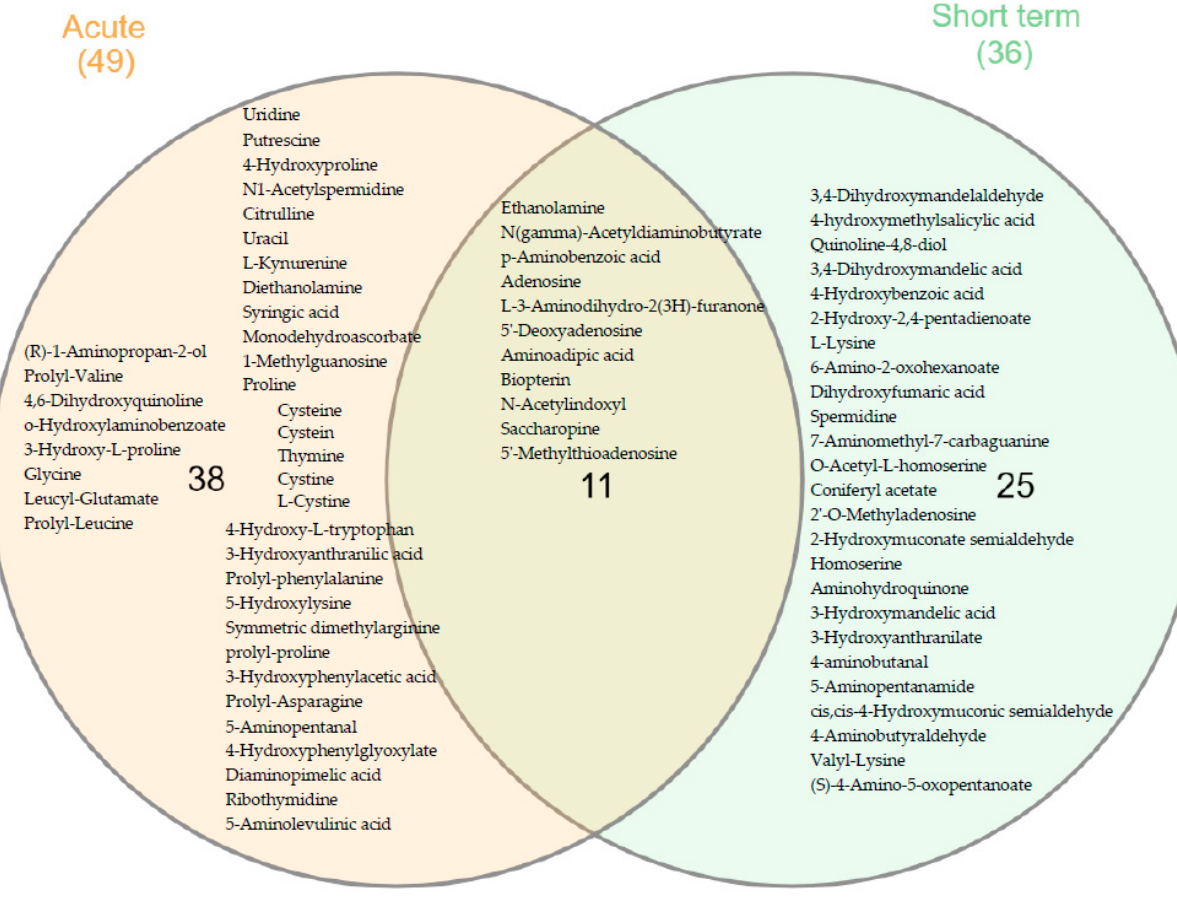
Figure 2. Venn diagram of the main discriminant metabolites identified after acute and medium-term intervention (only metabolites with VIP > 1.2 and p -value < 0.05 are shown).